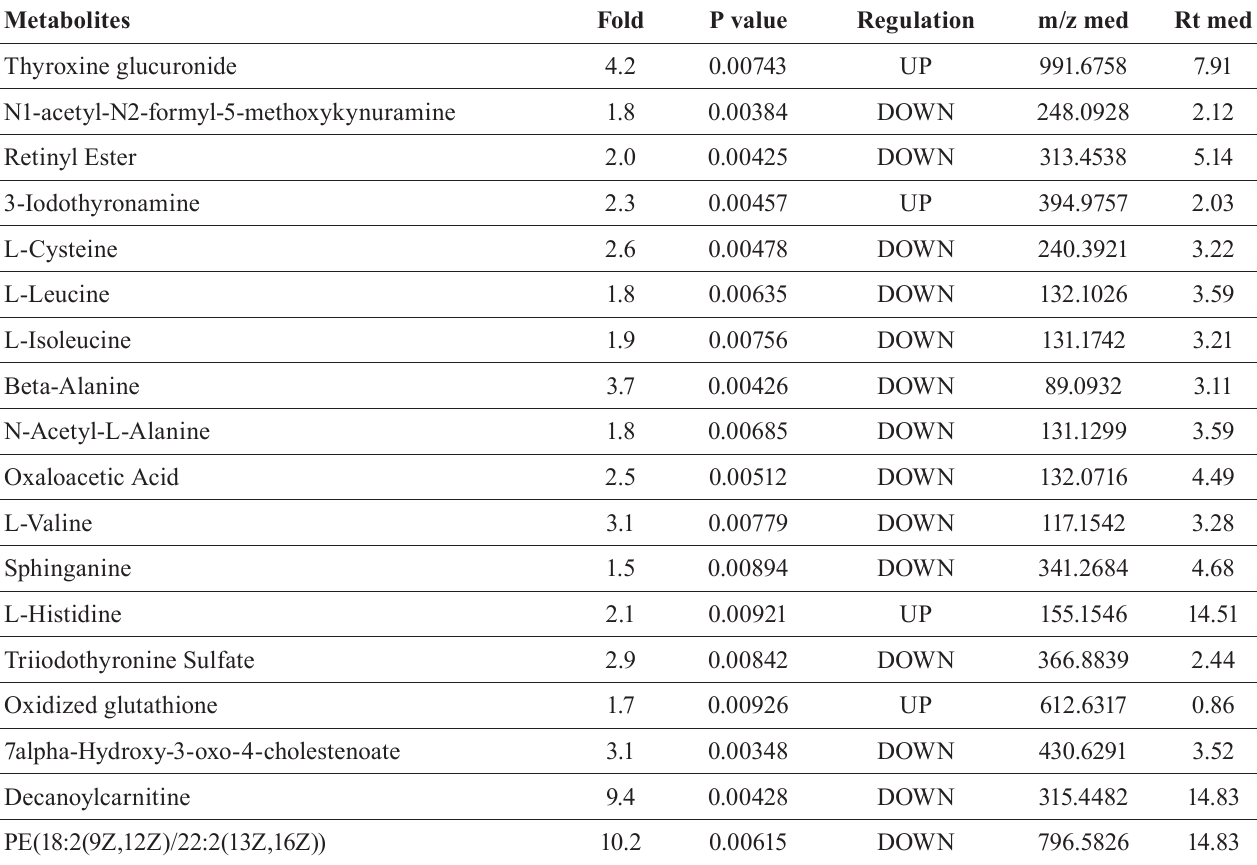
TABLE I - L ist of the significantly different metabolites identified in the drug group compared to the control group Metabolites Fold P